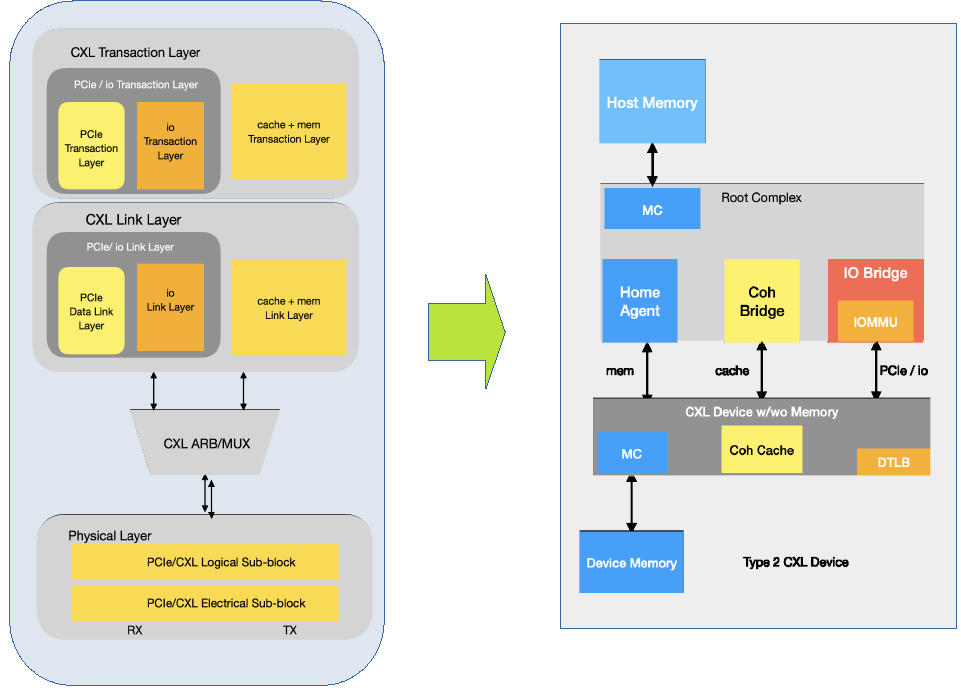
Figure 5. Flex bus layers for CXL